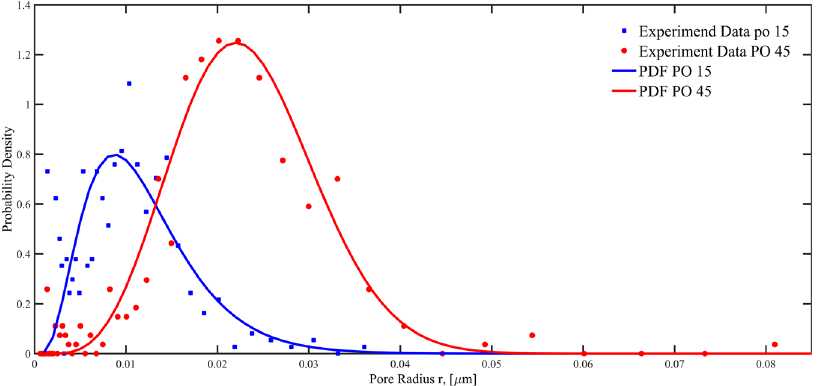
Figure 2. Nanoporous surface cavity probability density distributions for both PO15 and PO45